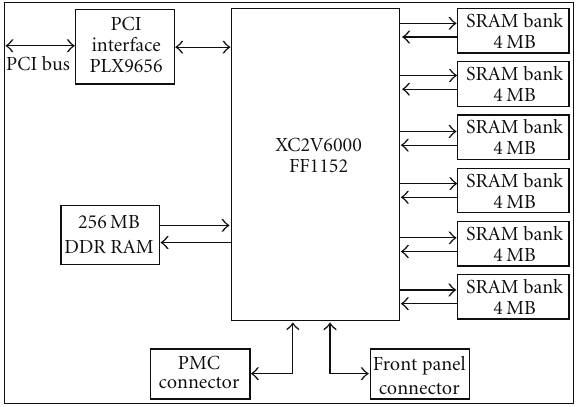
Figure 4: RC2000 reconfigurable computing board.